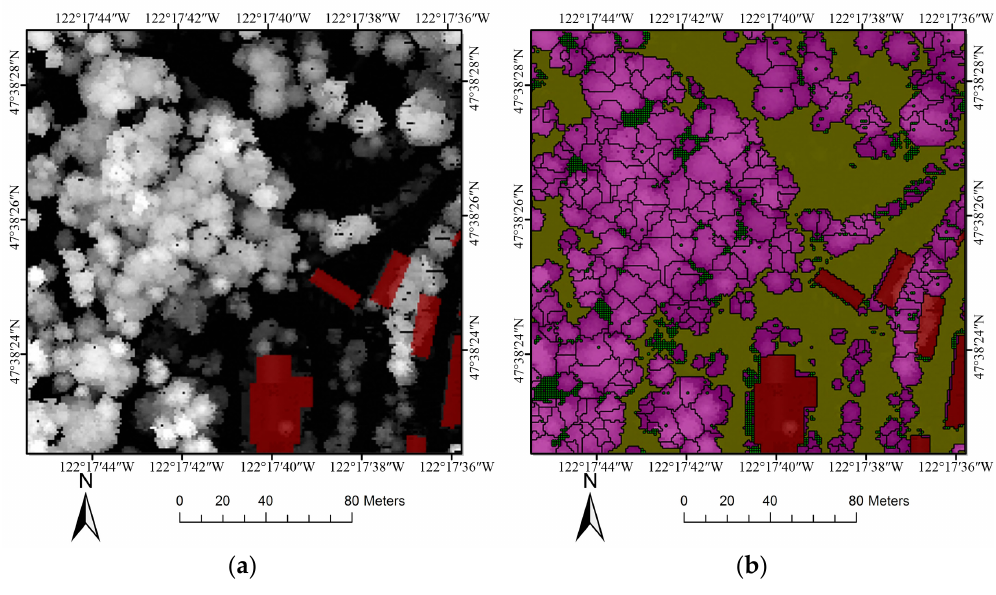
Figure 3. Segmentation process: ( a ) buildings were excluded by a thematic layer; and then ( b ) canopies were segmented into individual crowns.